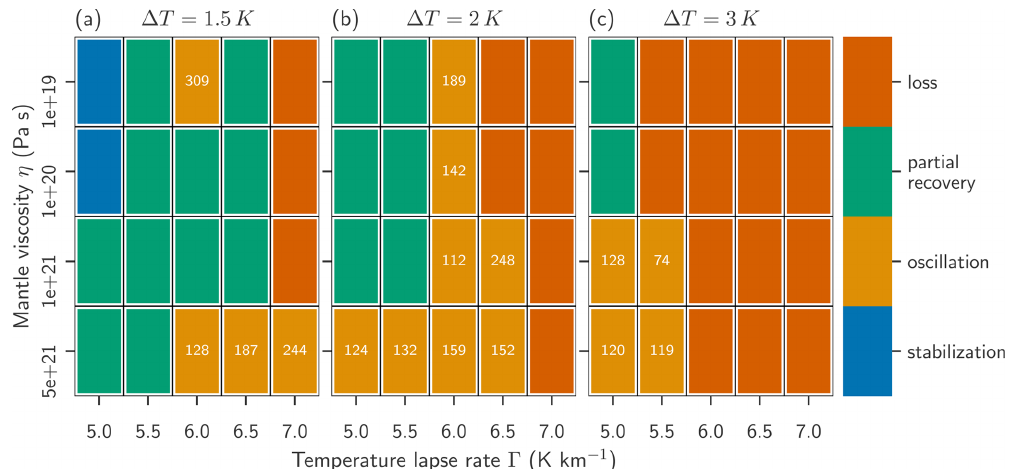
Figure 4. Blue indicates immediate stabilization to a stable state, which preserves more than 90% of the initial ice sheet volume, without passing a minimum. Green indicates that the ice sheet volume recovers permanently after passing a minimum first. Gold indicates that the ice sheet volume does not recover permanently but shows self-sustained oscillations on a long timescale instead. Dark orange indicates a permanent loss of ice sheet volume. The numbers in the gold tiles show the approximate oscillation